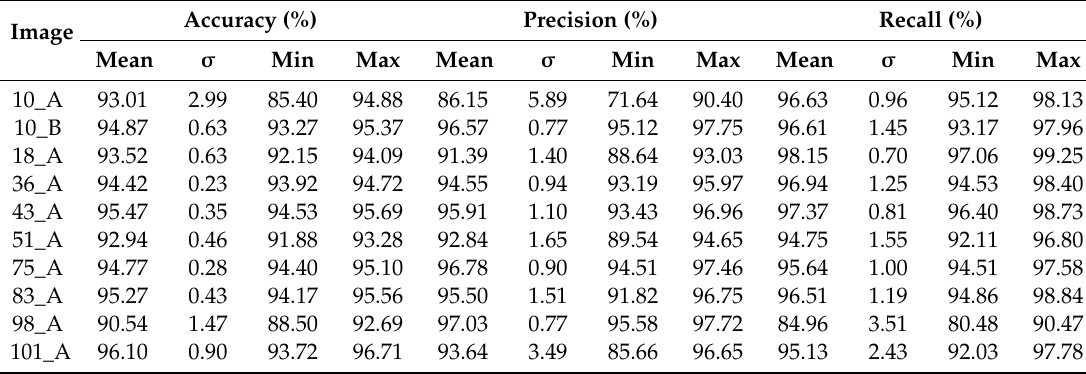
Table 8. Accuracy, precision and recall of whole images.